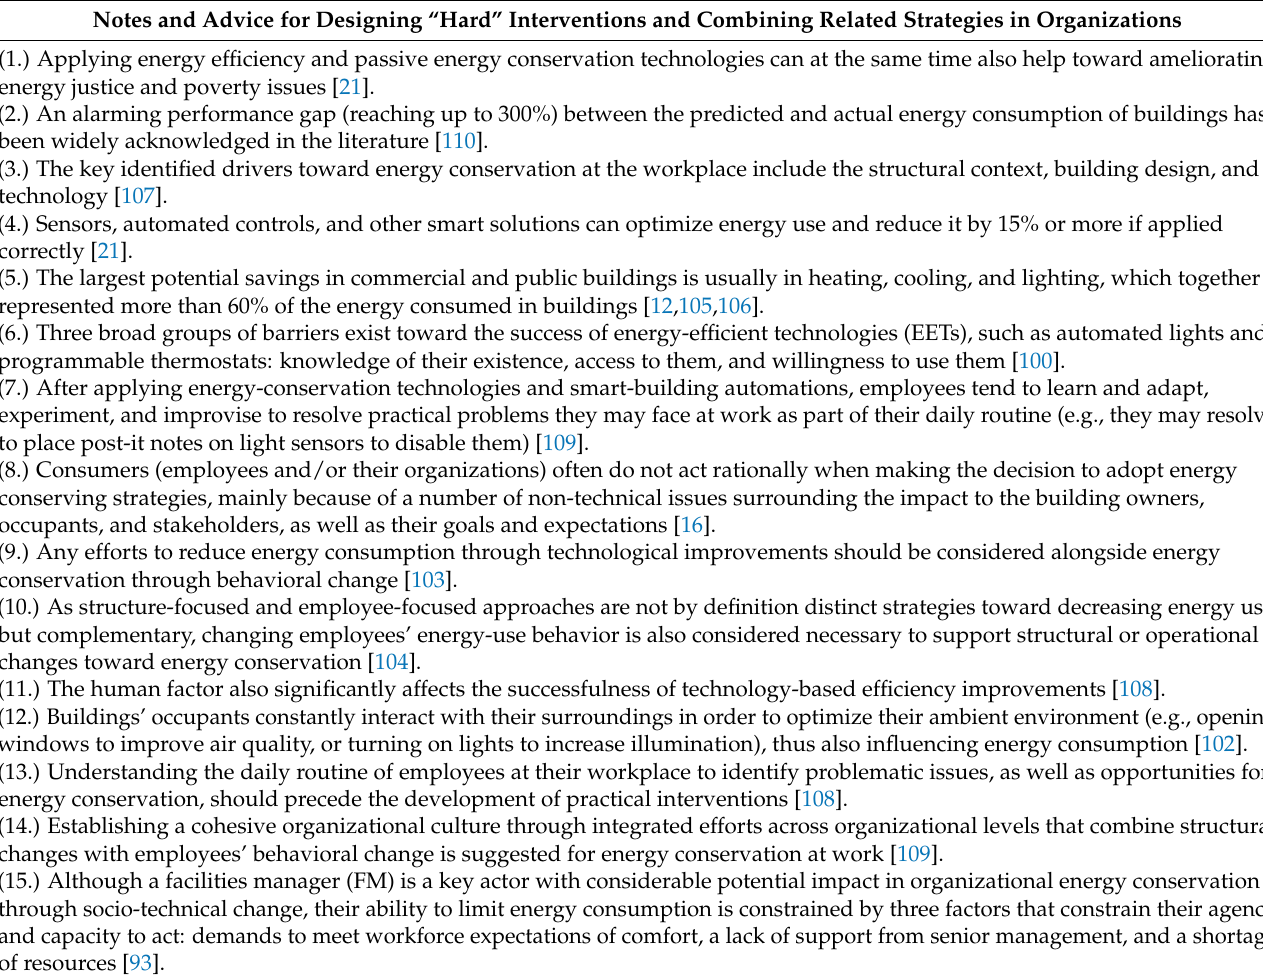
Table 4. Notes and advice for organizational energy efficiency through “hard” interventions